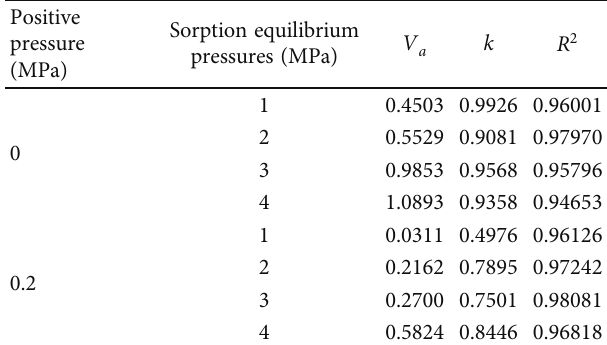
Table 2: Parameters of the gas desorption